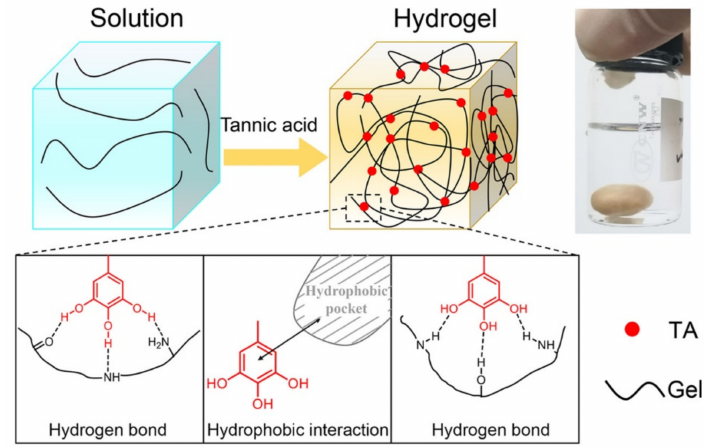
Figure 4. Scheme of the formation of the gelatin-tannic acid hydrogel. Tannic acid (TA) interacts with the gelatin chains through hydrogen bonds and hydrophobic interactions, forming crosslinks to the hydrogel network. Reprinted with permission from reference [87]. Copyright 2019 American Chemical Society.